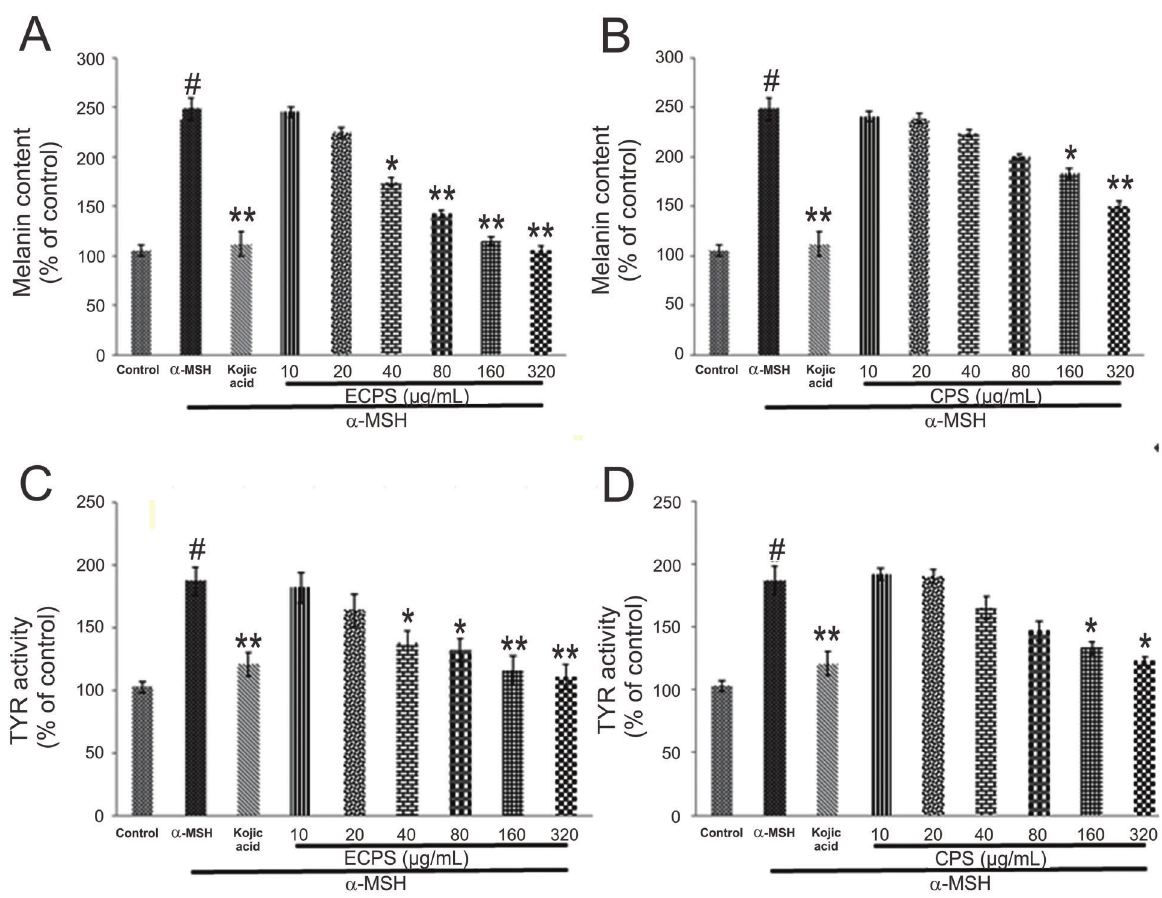
Figure 3. Effects of enzymatically hydrolyzed Cuscuta chinensis polysaccharides (ECPS) and Cuscuta chinensis polysaccharides (CPS) on B16F10 cells. Melanin content and tyrosinase (TYR) activity of melanoma cells were measured after ECPS ( A and C ) and CPS ( B and D ) treatment. Kojic acid (160 m g/mL) was used as positive control. Data are reported as means ± SD. # P o 0.01 compared to control group; *P o 0.05, **P o 0.01 compared to a -melanocyte stimulating hormone ( a -MSH) group (ANOVA followed by Dunnett ’ s